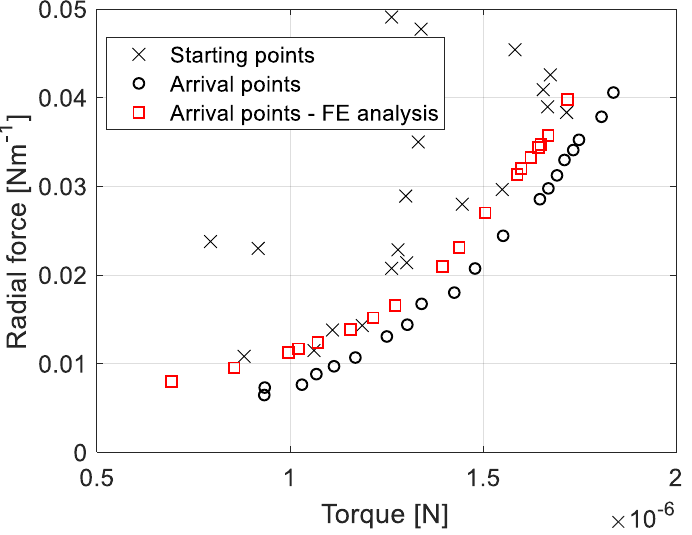
Figure 10. True values versus predicted values of the radial force value.